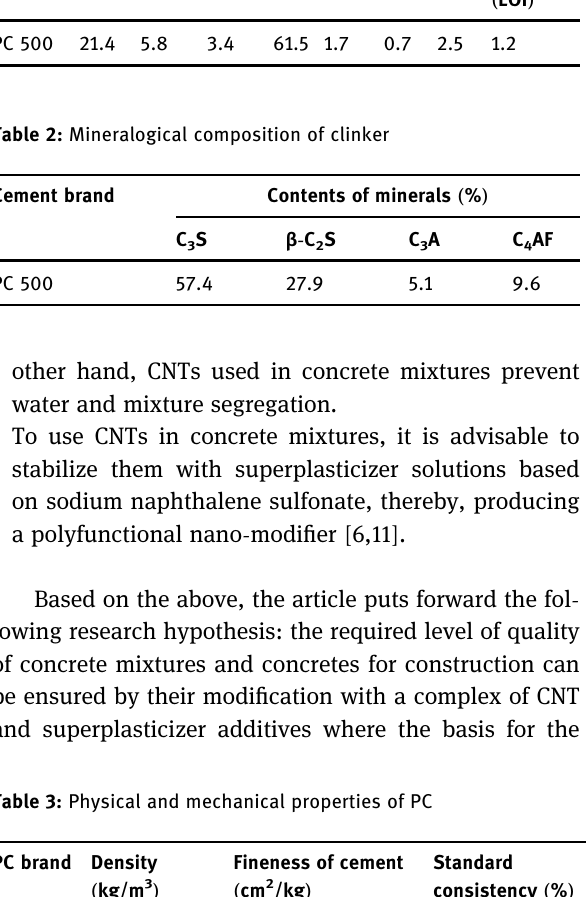
Table 1: Chemical composition of PC clinker Cement brand